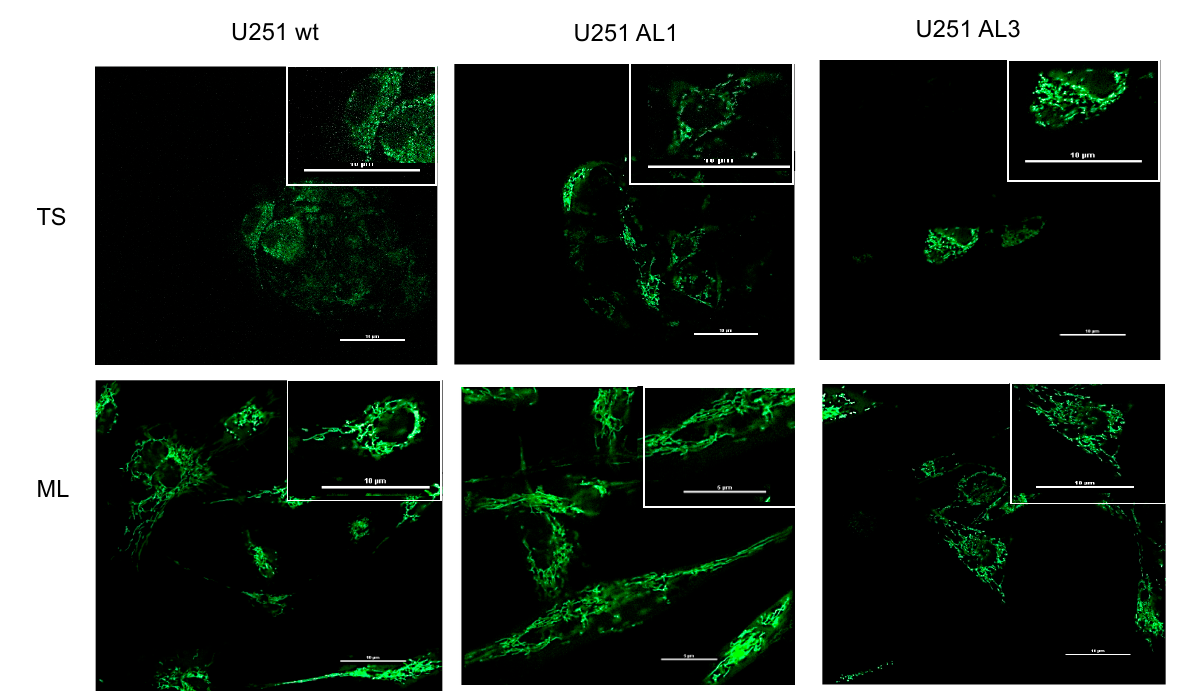
Figure 4. ALDH1L2 knockout alters mitochondrial morphology. ALDH1L2 knockout led to a visible change to the morphology of the mitochoindria of the KO TS cells. Relative to control wt TS cells, the mitochondria of the KO TS cells have a larger network-like structure, where, in wide type TS cells, the mitochochondria are much more fragmented with an oval-like shape. Mitochondria in U251 tumor spheres and in adherent U251 cells were labeled with green fluroescent protein (GFP) fused to the leader sequence of E1 alpha pyruvate dehydrogenase and observed under a confocal microscope (see supplemental Methods).